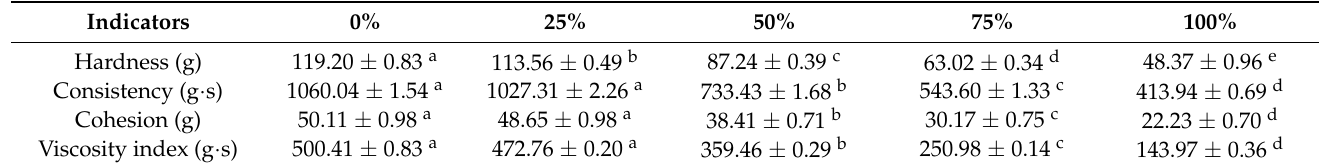
Table 2. Texture of yogurt with different substitution amounts of SOB replacing milk